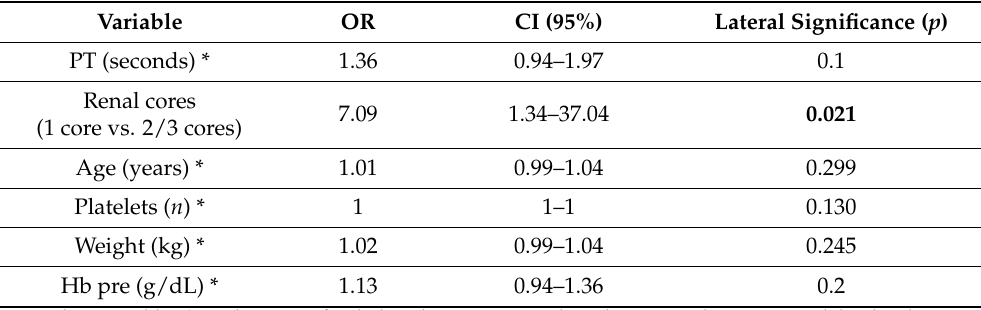
Table 6. Multivariate logistic binary regression analysis for independent risk factors of presenting complications after kidney